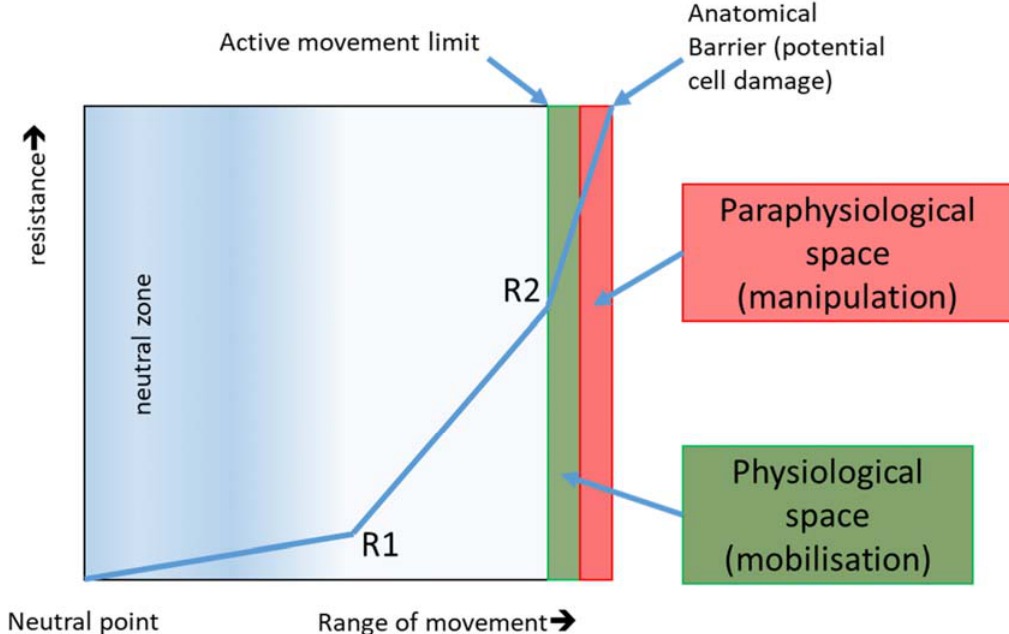
Figure 5. Behaviour of resistance depending on the extent of movement in joints and connective tissue. R1 represents the first and R2 represents the second remarkable increase in connective tissue resistance. Depending on the intensity of the manual degree classification (dosage), therapists treat passively more or less into physiological space. The paraphysiological space is only achieved by impulse mobilisation. If the anatomical barrier is crossed, cell damage occurs (lesion) and reacts with an inflammatory reaction. This anatomical barrier is important in post-traumatic and postoperative conditions due to adhesions and water soluble crosslinks to the front postponed. Especially in the proliferation phase, it can quickly lead to an overdose. The microtraumatic injuries trigger new inflammatory phases, which result in increased restriction of movement and restriction [25] (source: own